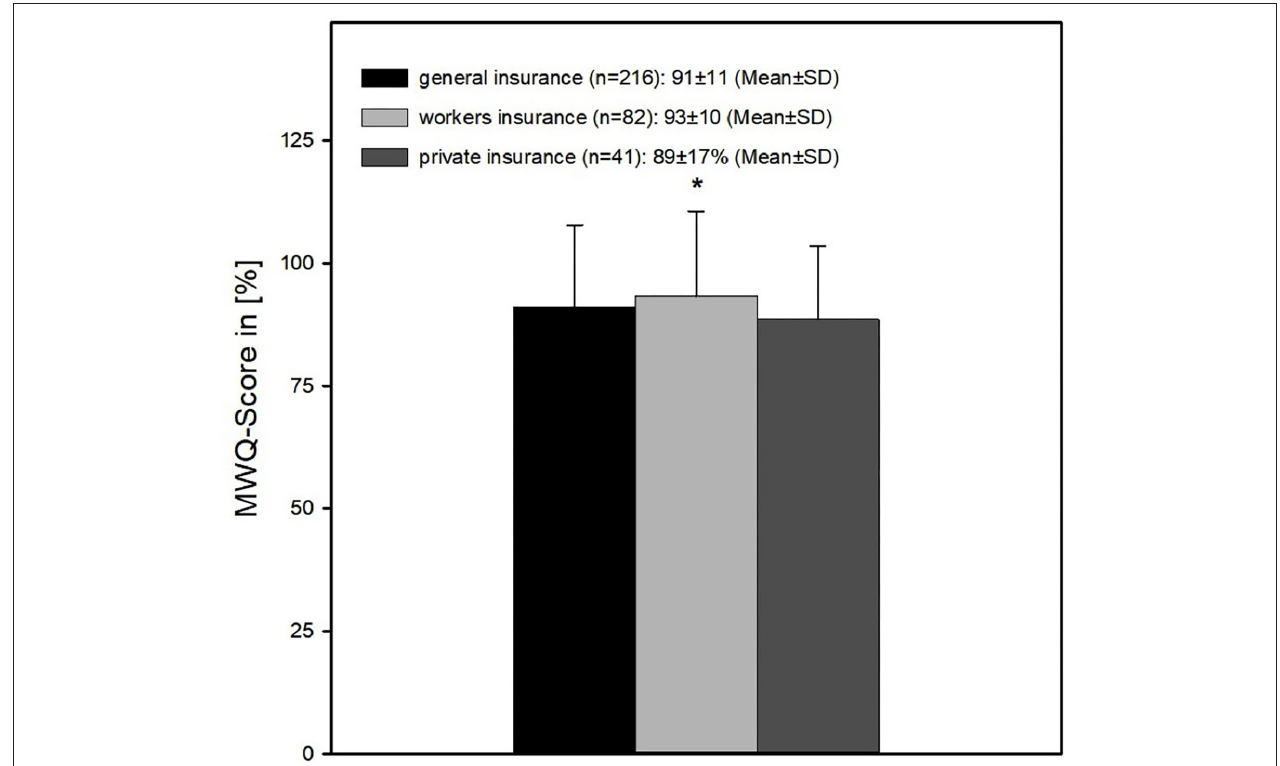
FIGURE 9 | Wrist function in respect of insurance type. The outcome was significantly better of patients with a workers insurance compared to patients with a general insurance (* = 91 ± 11% vs. 93 ± 10%; p < 0.05 MWUT). Patients with a private insurance (MWQ: 89 ± 17%) had no significant difference to both other